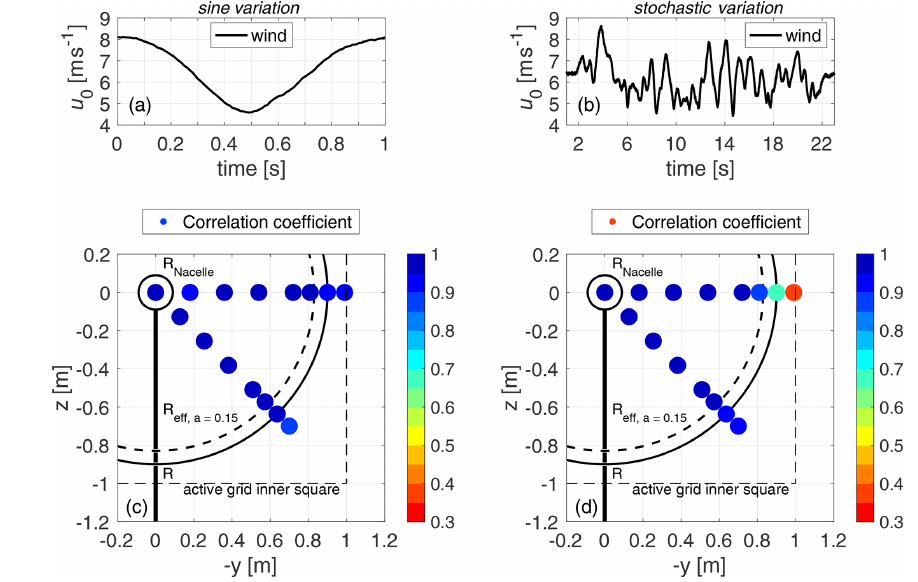
Figure 2. Undisturbed mean wind field of the sine (a) and stochastic (b) variation. Front view on the lower-right-hand-side quarter of the swept area of the turbine looking downstream. The colour-coded measurement positions show the Pearson correlation coefficient of the local measurement position wind velocity to the mean wind velocity for the sine (c) and stochastic (d) variation.